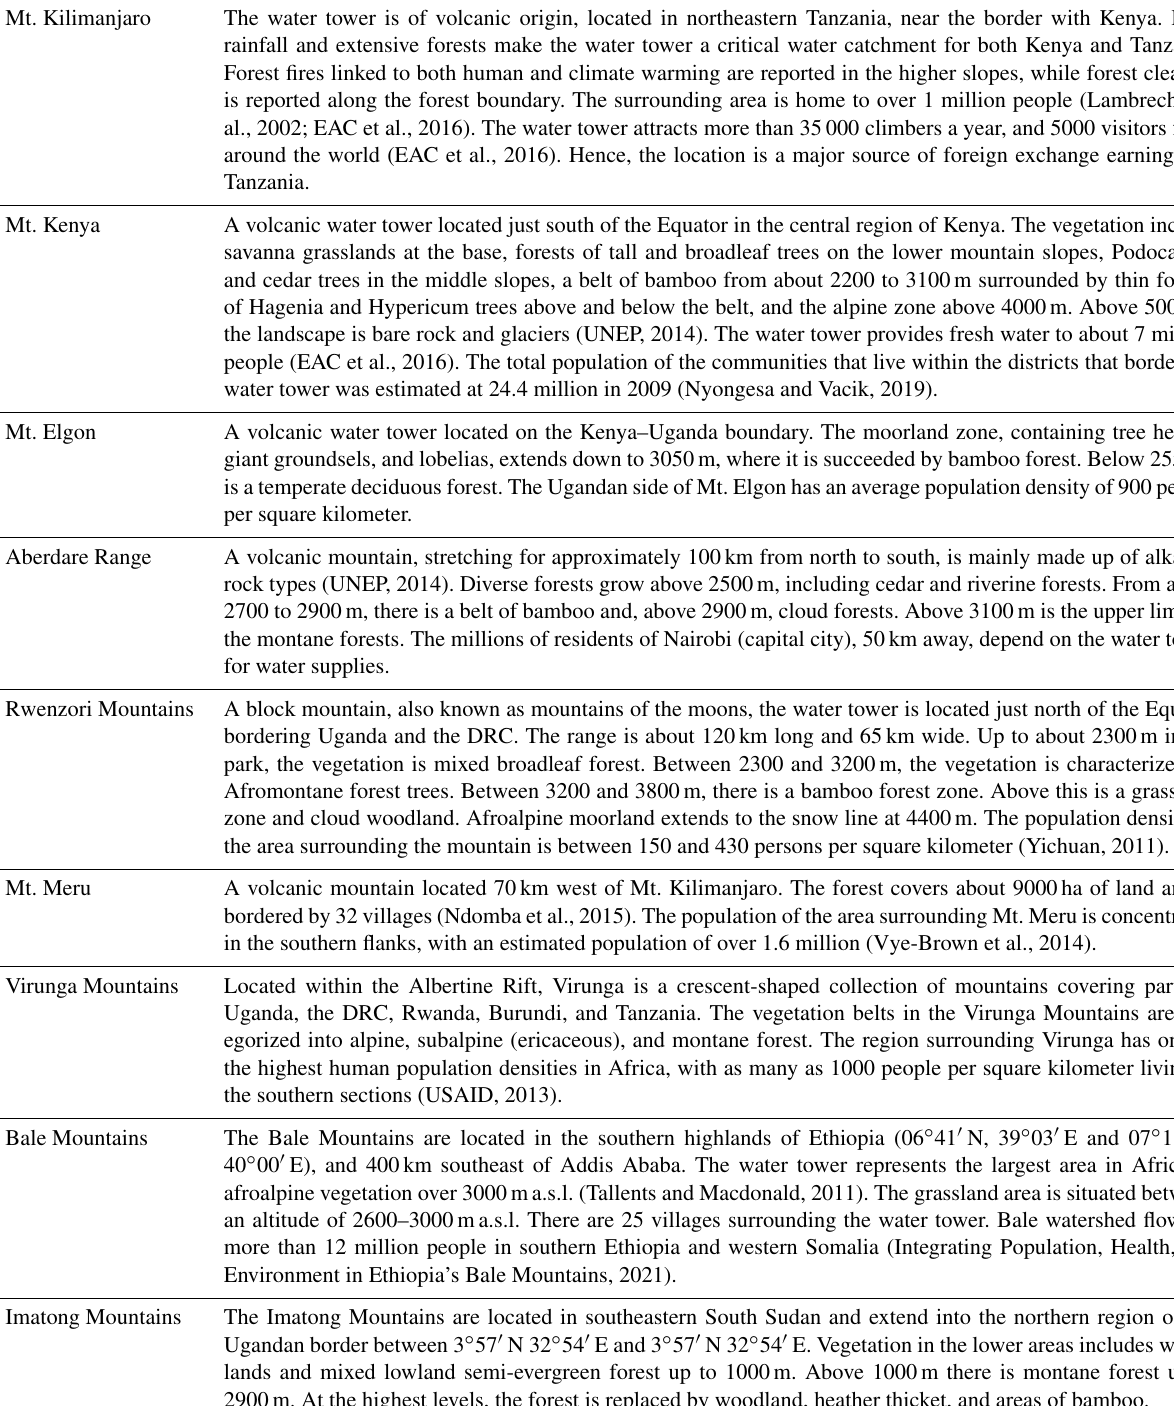
Table A2. Description of the selected water towers. Mt.